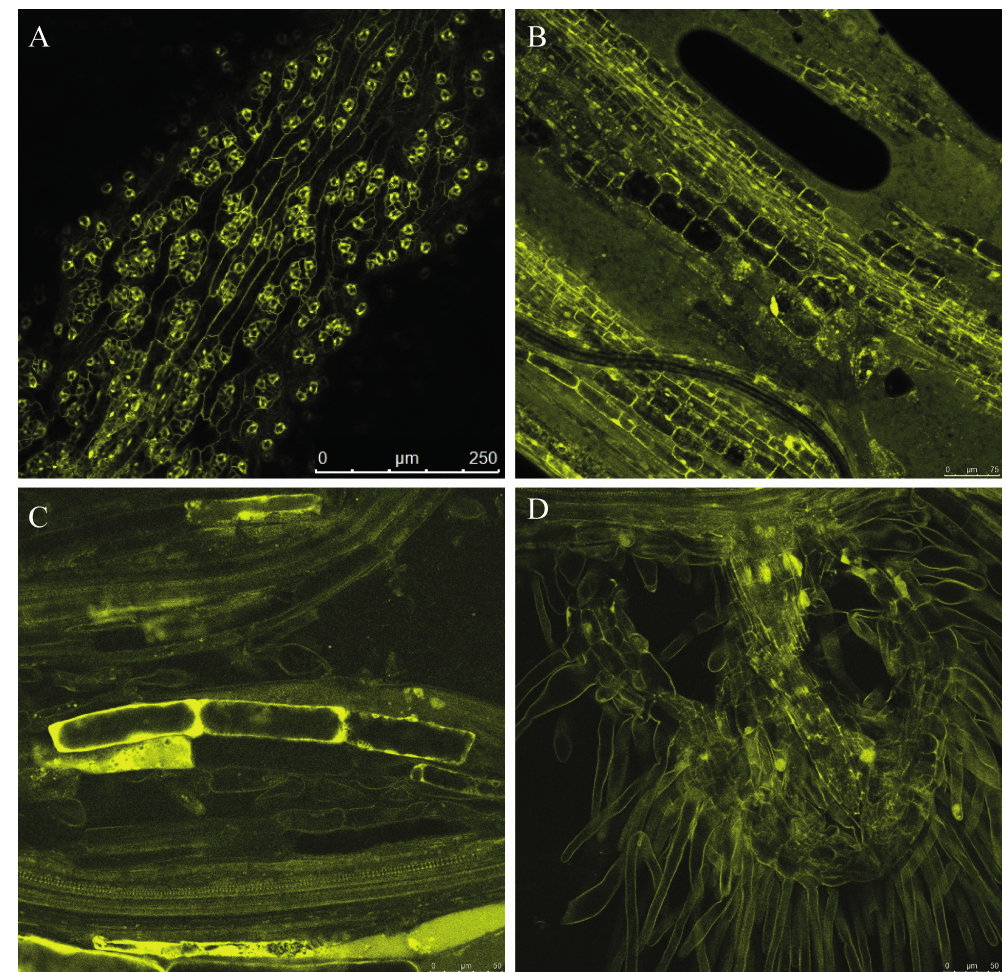
Figure 3. ZjMT is localized to cytoplasm and nucleus. ZjMT-YFP fusion proteins were